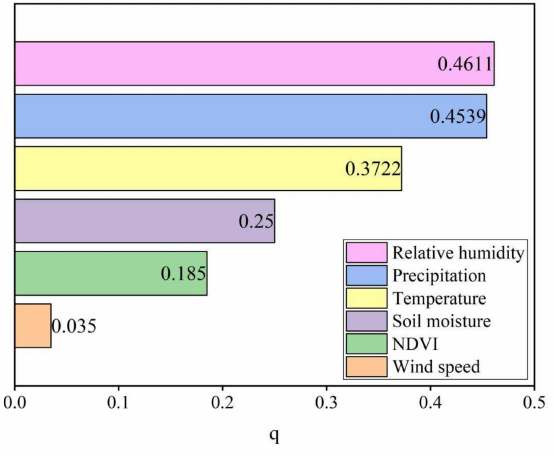
Figure 11. Single-factor detection